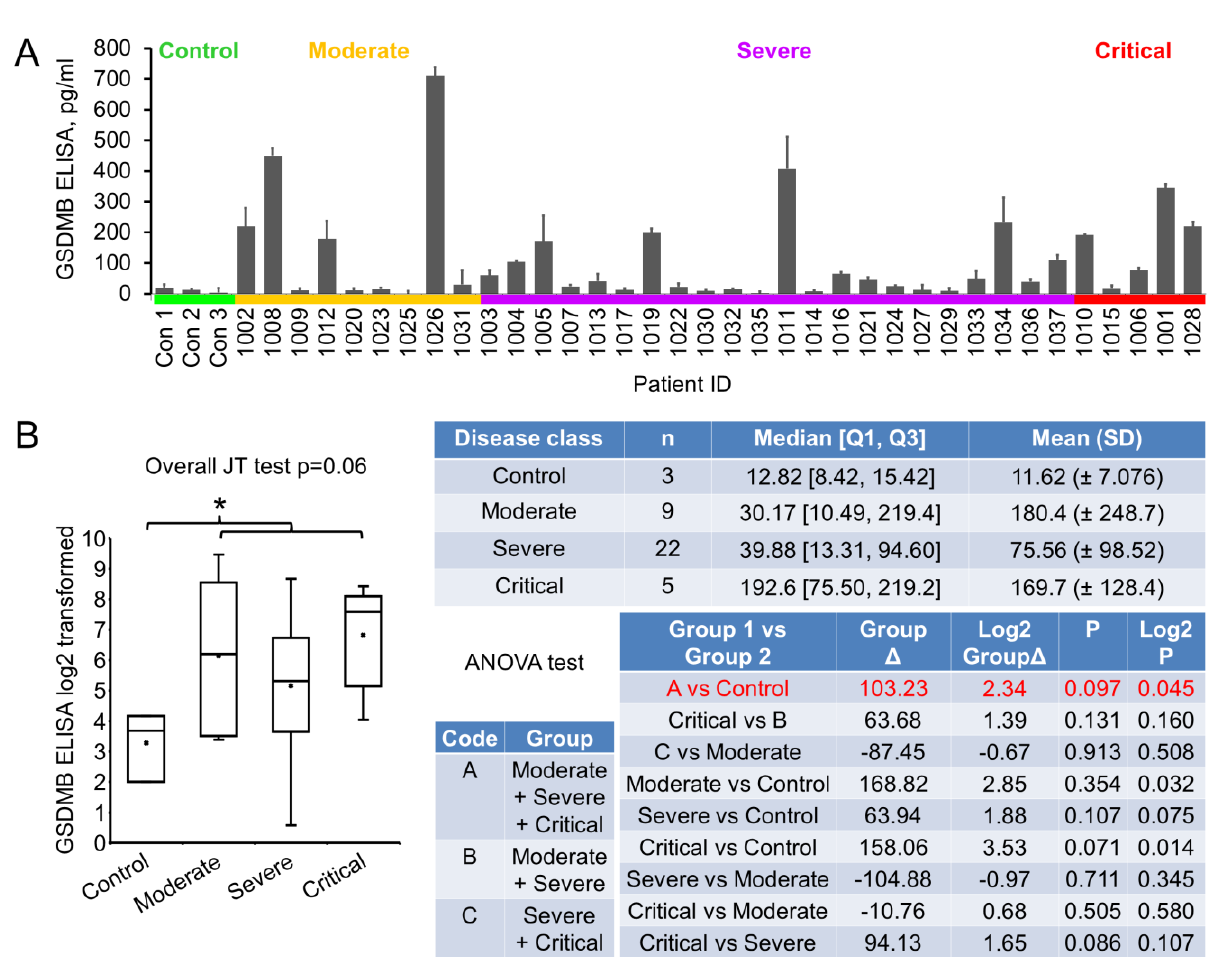
OPEN ACCESS | www.cell-stress.com